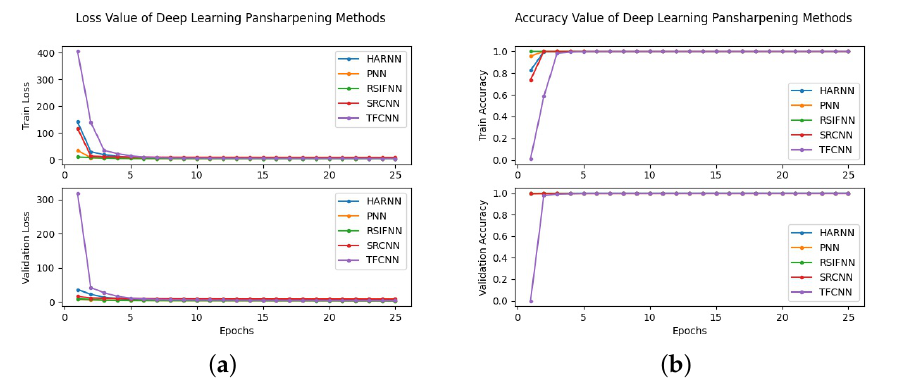
Figure 8. Loss and accuracy curve of comparison DL-based methods on GF-1 dataset: ( a ) Loss Curve, ( b ) Accuracy